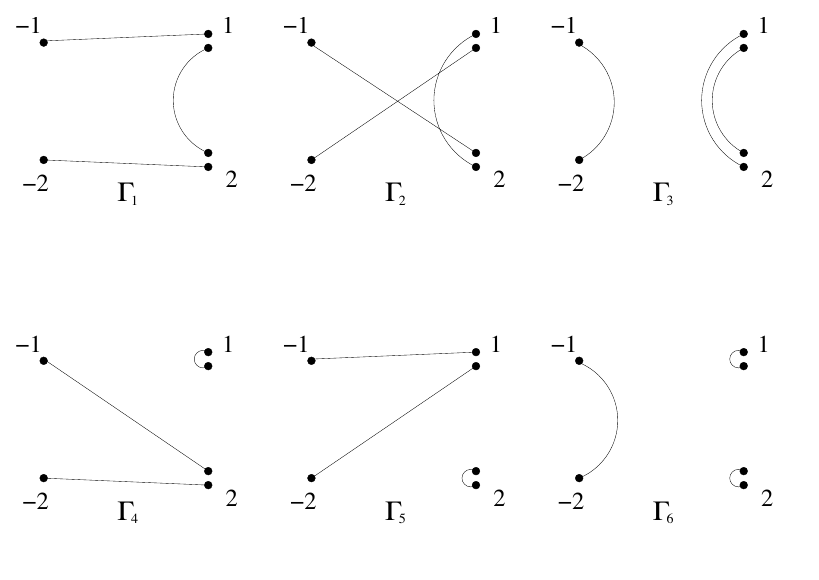
Figure 2 . Dipole graphs for q ¯ q → gg . In the cases of Γ 4 , Γ 5 , and Γ 6 the corresponding self- connected gluons are also